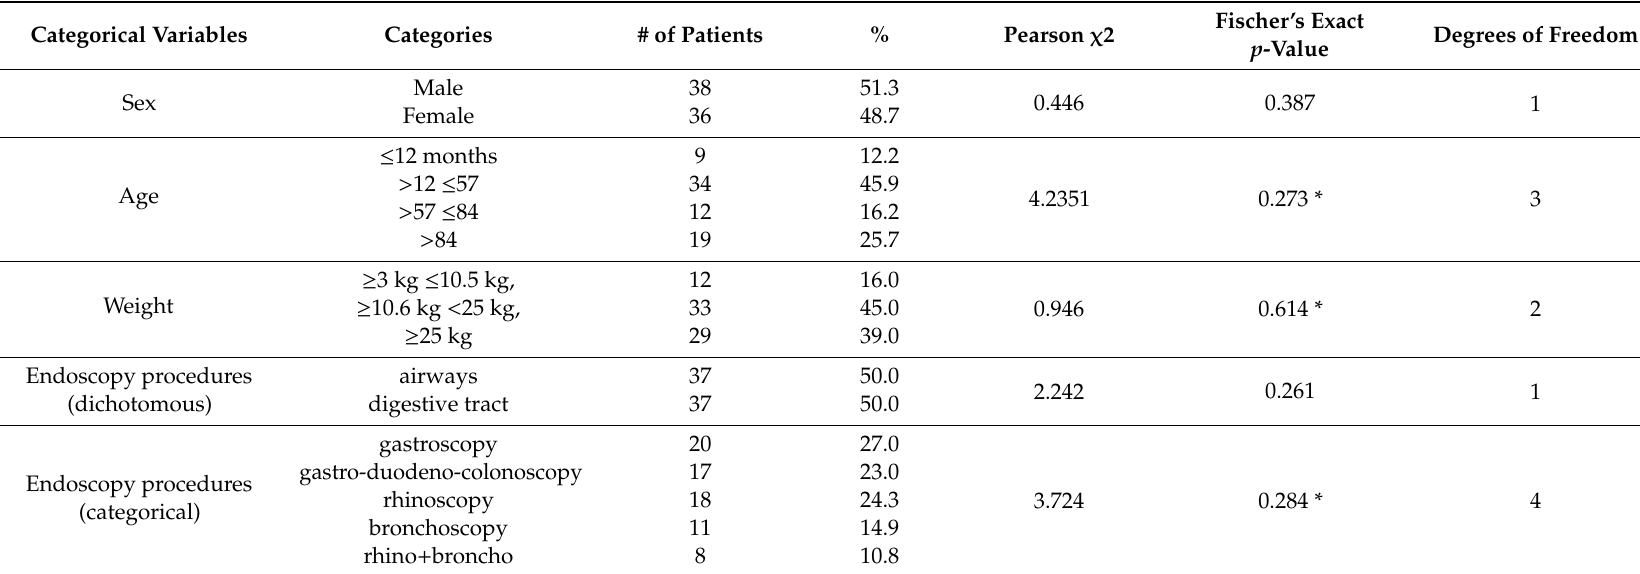
Table 2. Pearson χ 2 comparison between the categorical variables and the hemoculture